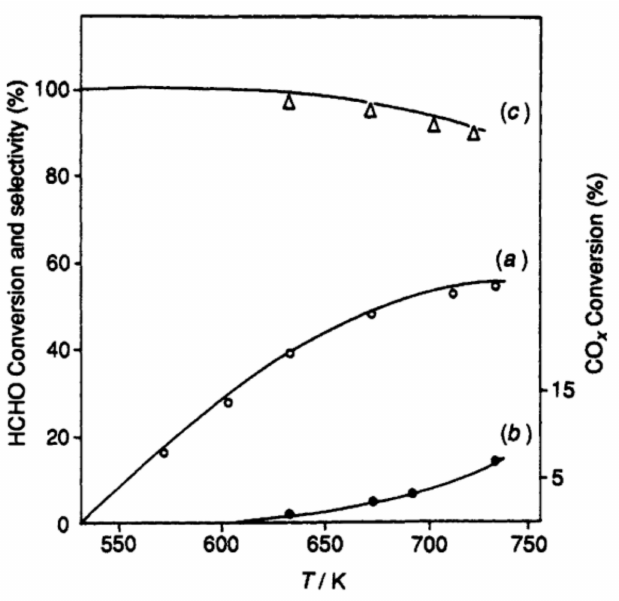
Figure 48. MeOH conversion (line a), FA selectivity (line b), and CO 2 selectivity (line c) on Fe(III) phosphate as function of temperature in 240 mL/min 4 vol.% MeOH in air. Reproduced from [242] with permission from the Royal Society of